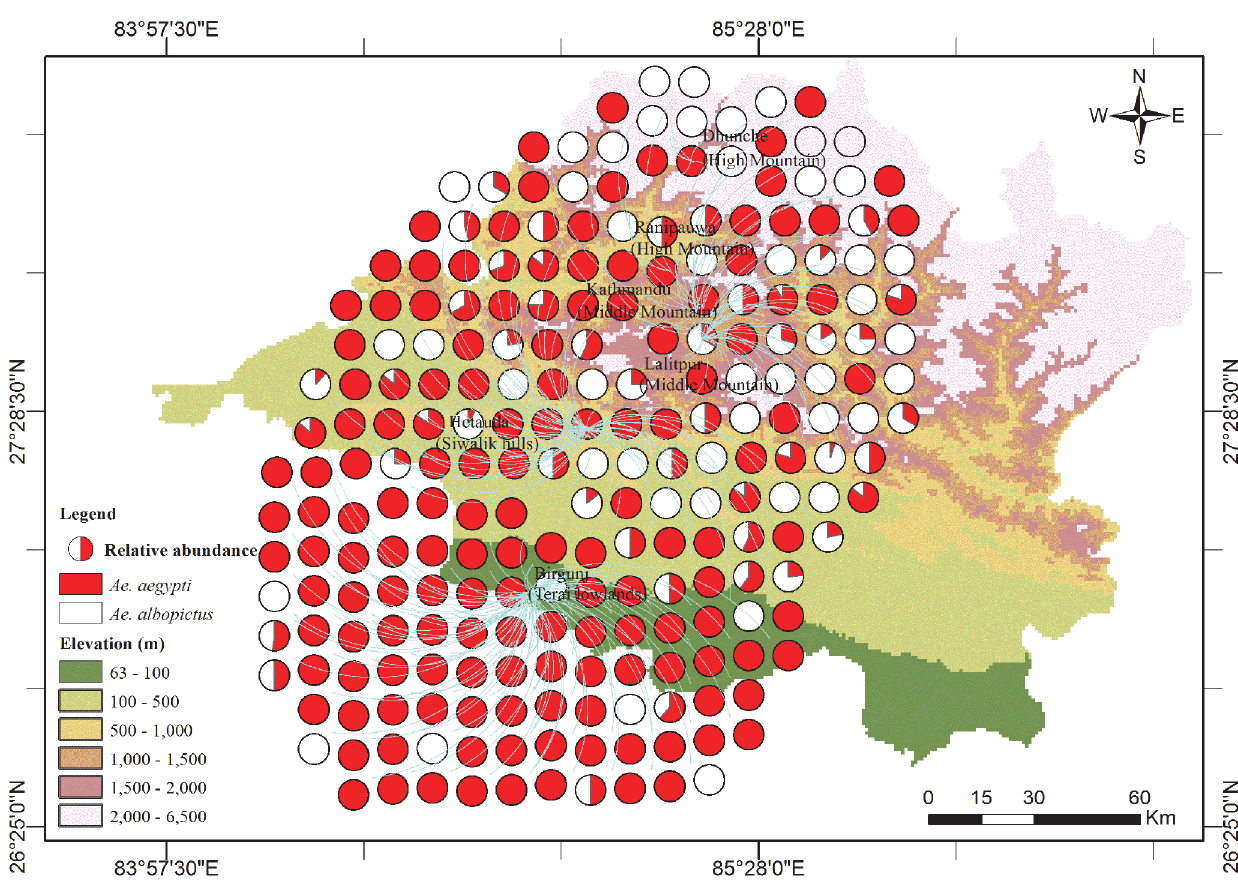
Fig 2. Relative abundance of Aedes aegypti and Aedes albopictus in central Nepal. Each pie-chart represents positive containers for the chikungunya and dengue virus vectors Aedes aegypti and Aedes albopictus and their